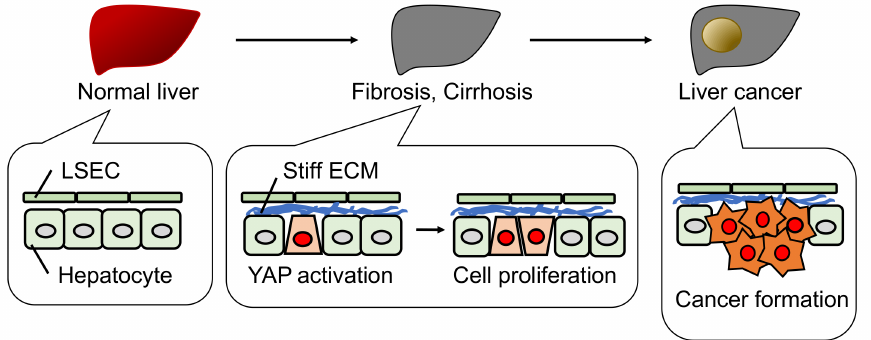
Figure 4. Schematic model of liver cancer formation. In fibrosis and cirrhosis, a stiff ECM activates YAP and promotes hepatocyte proliferation, but not hepatocyte elimination as shown in Figure 3. This pathological situation can lead to liver cancer